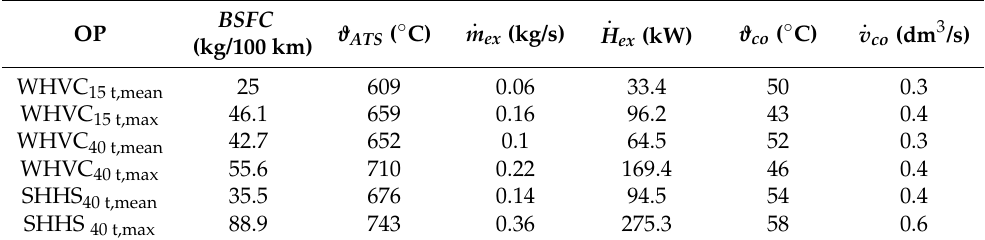
natural gas HDV.